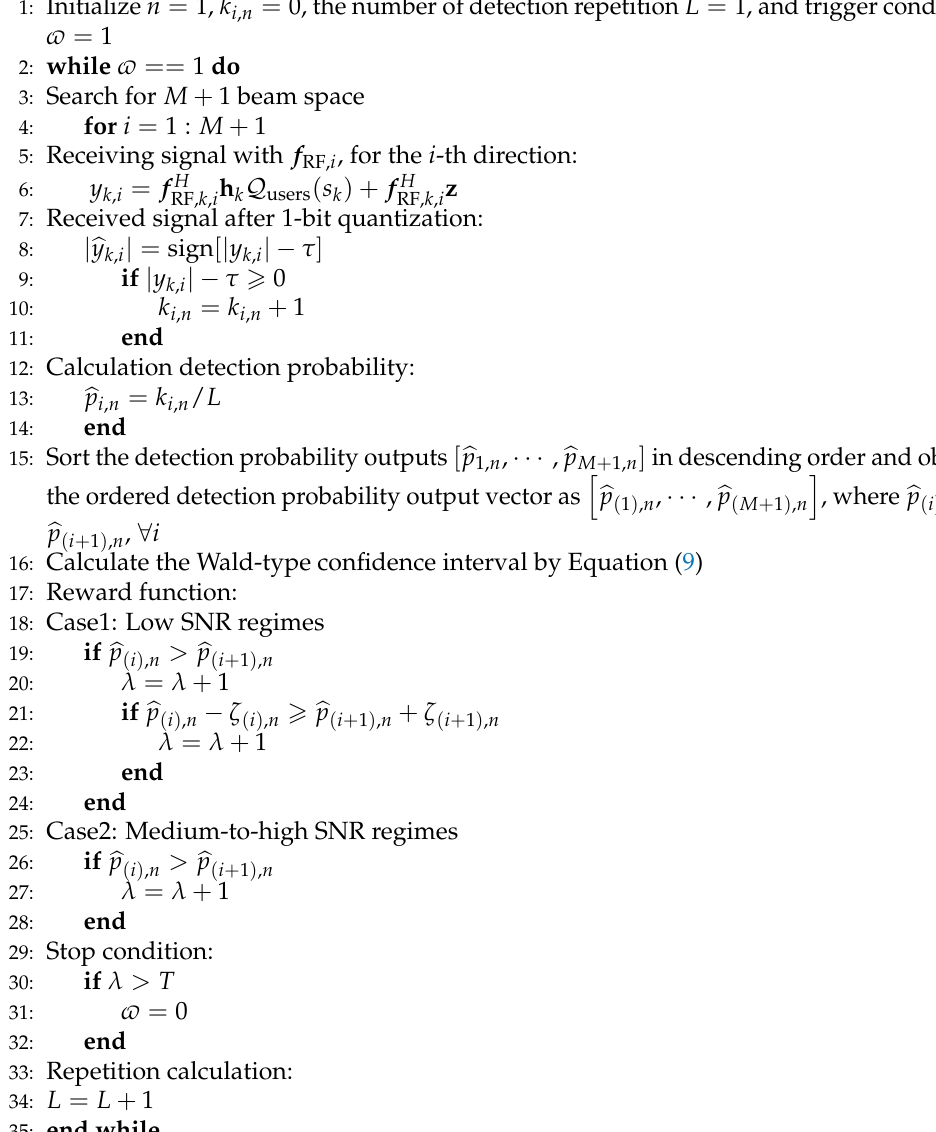
Algorithm 1 Beam Searching for Strongest AoA Components